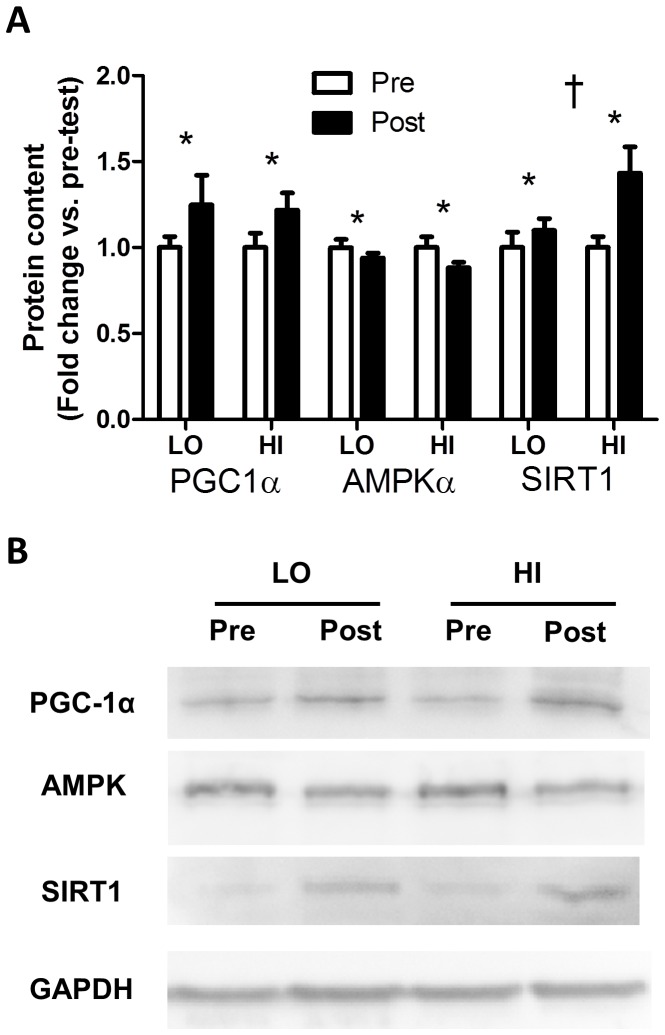
Effects of HI and LO on PGC-1α, AMPK, and SIRT1 protein content.Changes in the protein content of PGC-1α, AMPK and SIRT1 (A). Representative western blots, including loading controls, are also shown (B). * Significant (p<0.05) effect of training. † Significant (p<0.05) interaction.